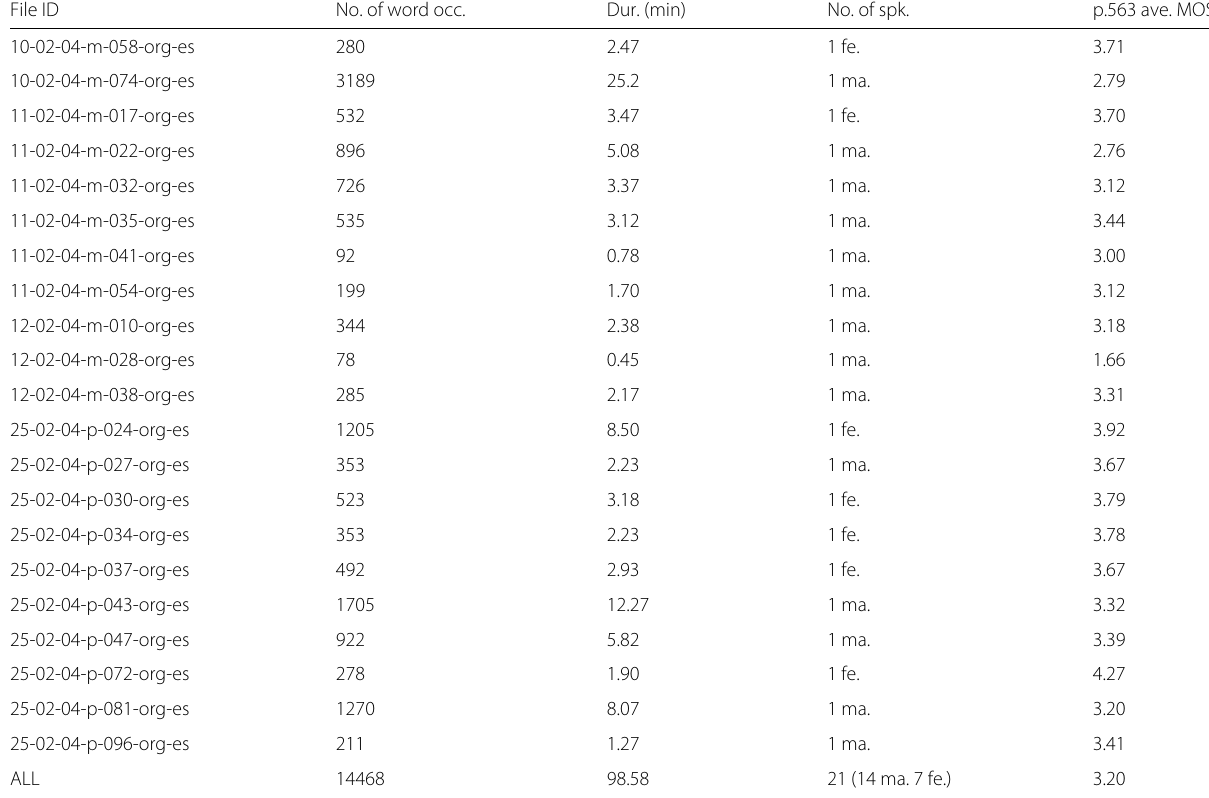
Table 2 Summary of EPIC database File ID No. of word